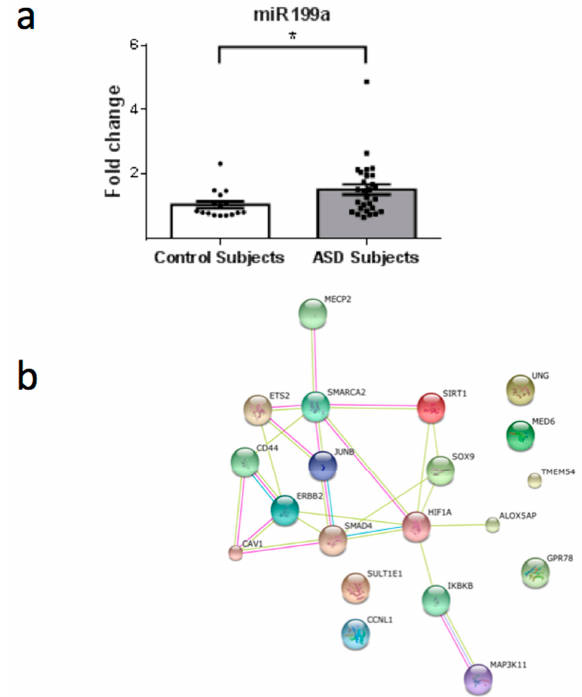
Figure 4. ( a ) Scatter plot of differential relative expression of miR199a in peripheral blood of ASD subjects compared to control subjects. Results expressed as mean ± standard error. t -Test analysis; * p < 0.05. ( b ) mRNA validates targets for miR199a selected in miRBase and respective proteins clusters that can be involved in ASD. Proteins involved in epigenetic regulation: SIRT1 (sirtuin 1); SOX9 (SRY (sex determining region Y)-box 9); MED6 (mediator complex subunit 6); SMARCA2 (SWI/SNF related, matrix associated, actin dependent regulator of chromatin, subfamily a, member 2); CCNL1 (cyclin L1); JUNB (jun B proto-oncogene); HIF1A (hypoxia inducible factor 1, alpha subunit); ETS2 (v-ets erythroblastosis virus E26 oncogene homolog 2); MECP2 (methyl-CpG binding protein 2). Proteins involved in immunological regulation: CAV1 (caveolin 1); SMAD4 (SMAD family member 4); ALOX5AP (arachidonate 5-lipoxygenase-activating protein); CD44 (CD44 molecule); IKBKB (inhibitor of kappa light polypeptide gene enhancer in B-cells). Protein associated with cytoskeleton and cell migration: ERBB2 (v-erb-b2 erythroblastic leukemia viral oncogene homolog 2). Protein involved in DNA repair: UNG (uracil-DNA glycosylase). Protein involved in strogen metabolim: SULT1E1 (sulfotransferase family 1E, estrogen-preferring, member 1). Others: MAP3K11 (mitogen-activated protein kinase kinase kinase 11); TMEM54 (transmembrane protein 54); GPR78 (G protein-coupled receptor 78; Orphan